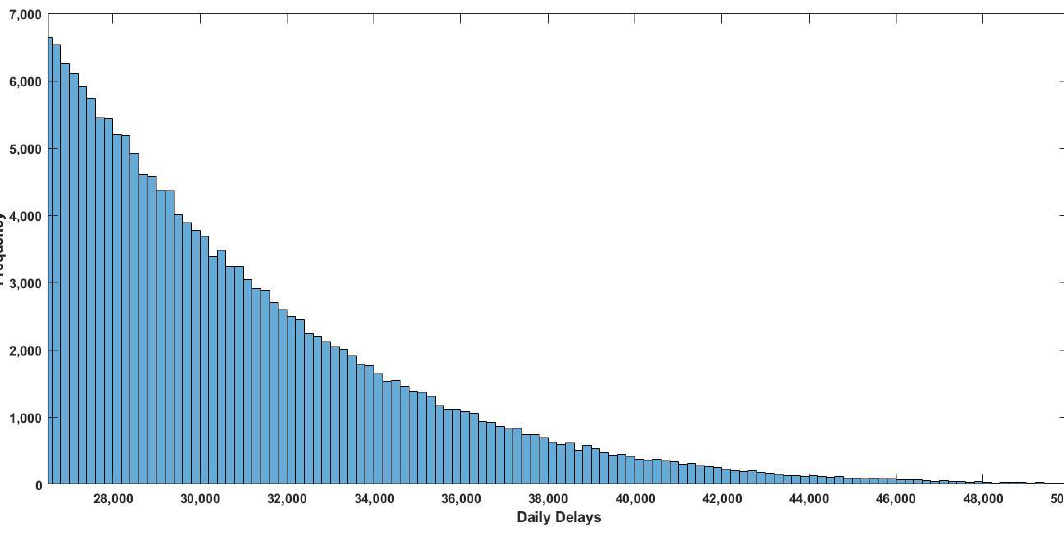
Figure 12. Simulation tail of daily delays for year 2019 (all daily